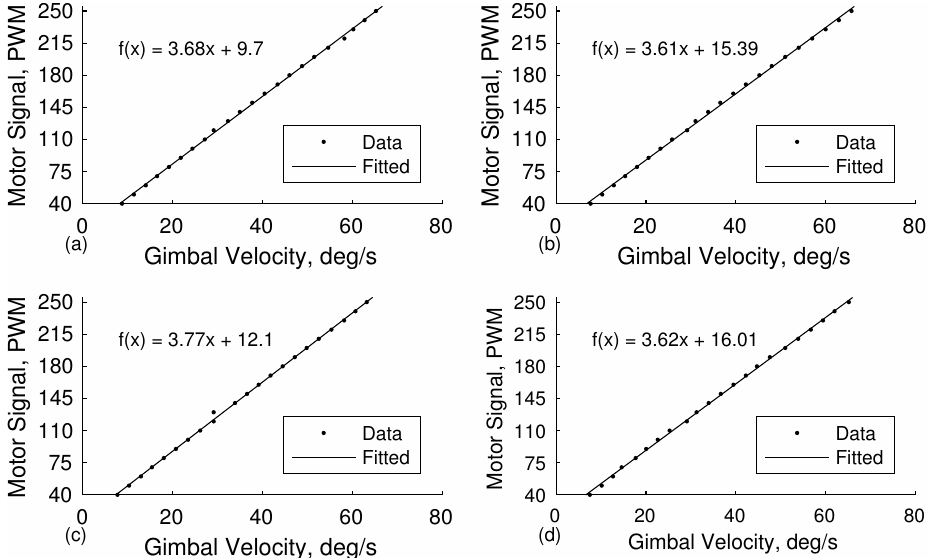
Figure 8. Deg/s-PWM Relation for ( a ) Gimbal 1, ( b ) Gimbal 2, ( c ) Gimbal 3, ( d ) Gimbal